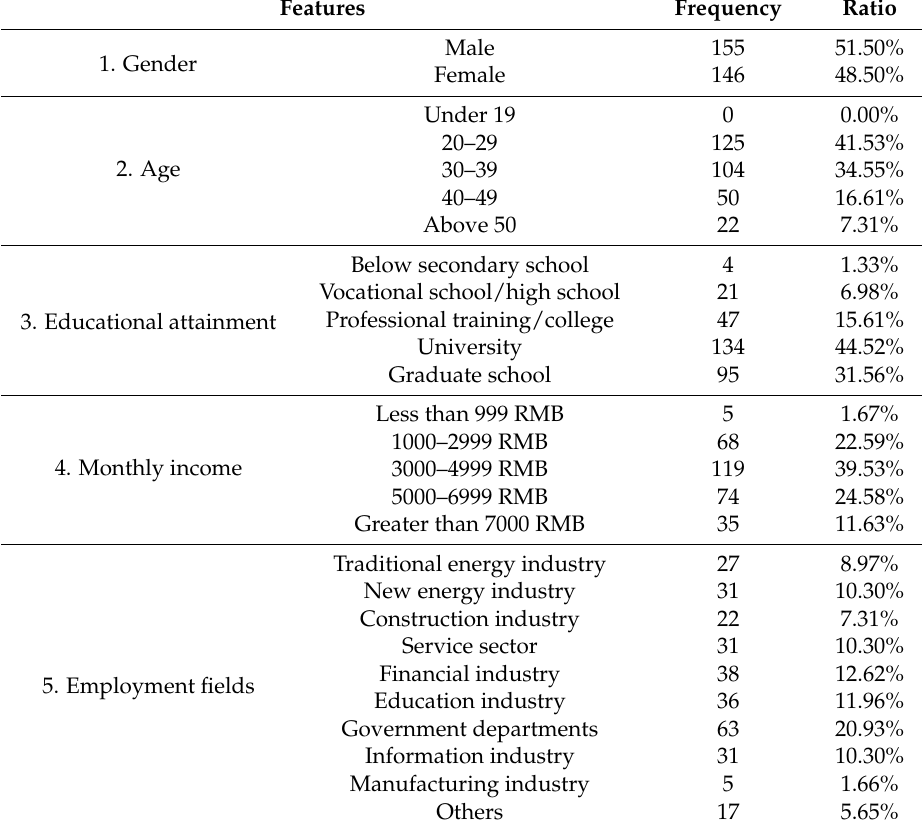
Table 1. The distribution of